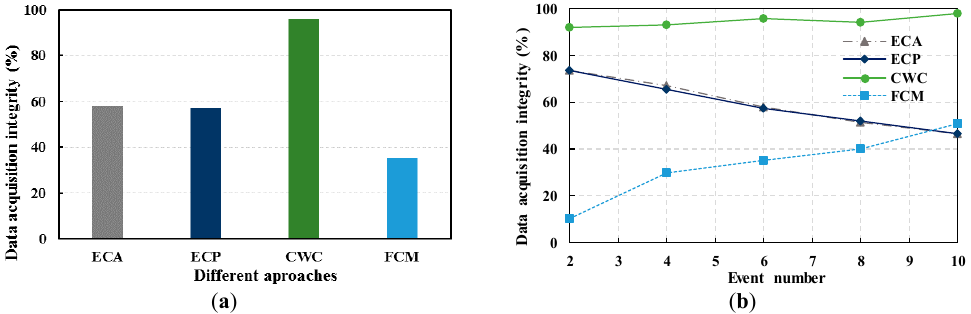
Figure 4. Comparison of Integration of Data Acquisition. ( a ) Integration of Data Acquisition with 10